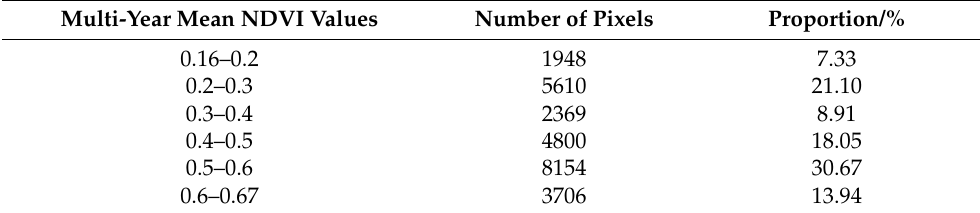
Table 2. Number of pixels and proportion of different types of multi-year mean NDVI in Shaanxi province during